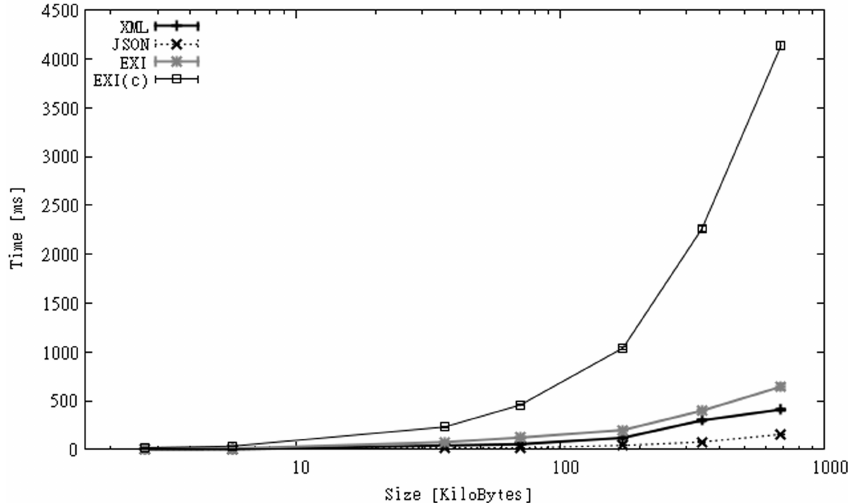
Figure 10. Serialization times for SGS2 smartphone (IO dataset).